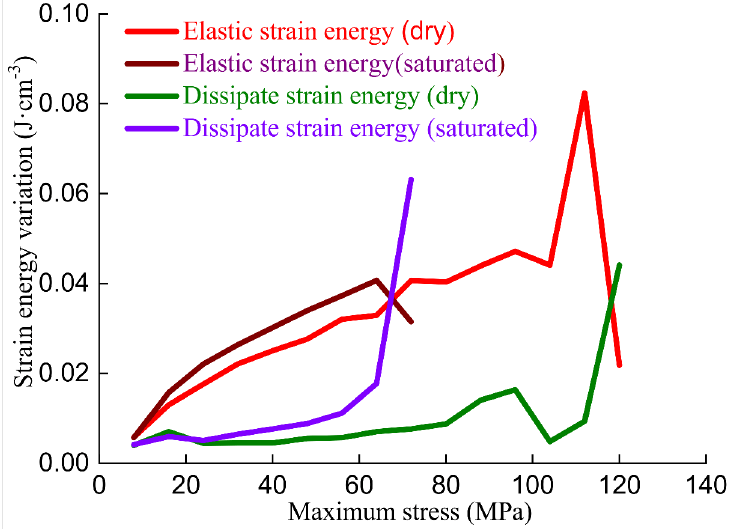
Figure 9. The curve of strain energy changes with maximum